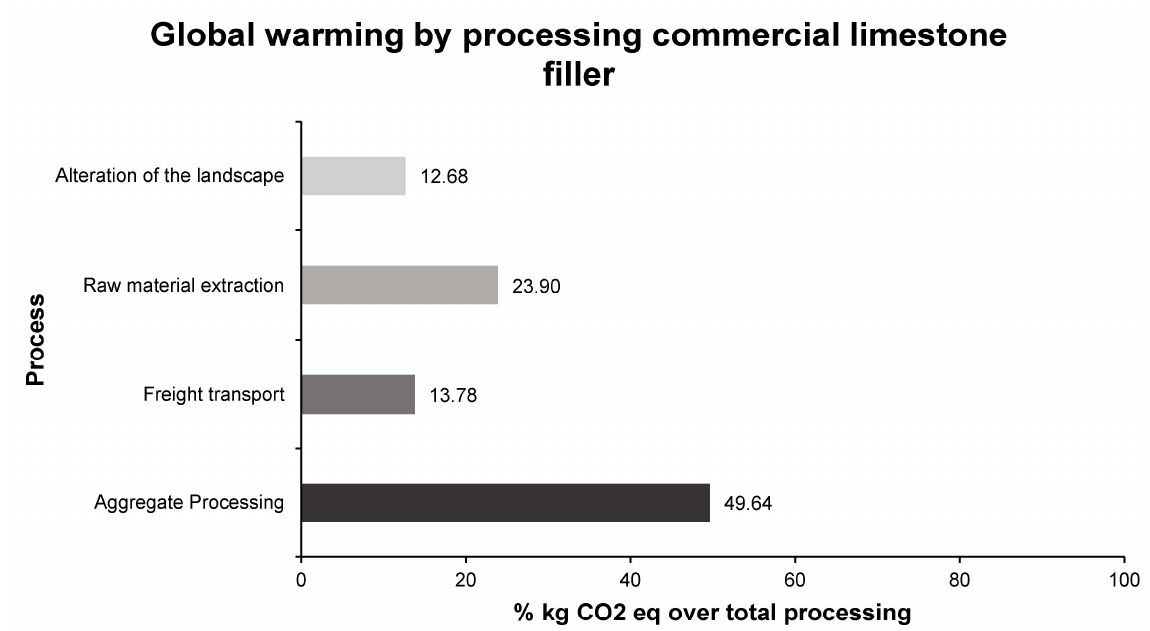
Figure 4. Percentages of kg of CO 2 by stages of the process of obtaining commercial limestone filler for use in bituminous mixtures.